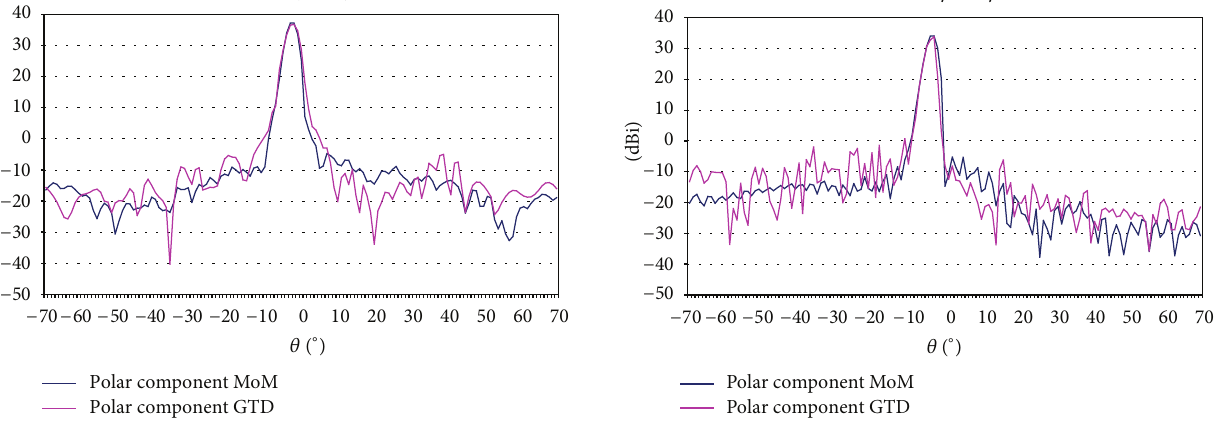
Figure 20: Polar component obtained with MoM and GTD, cut in phi = 0.